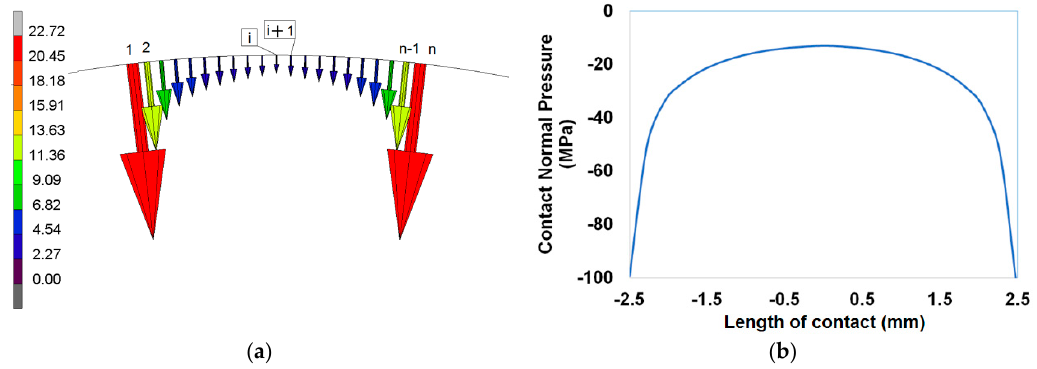
Figure 10. Normal contact force on the pin with a value of 1 kN ( a ) and normal contact pressure ( b ) obtained in the FEM simulations.